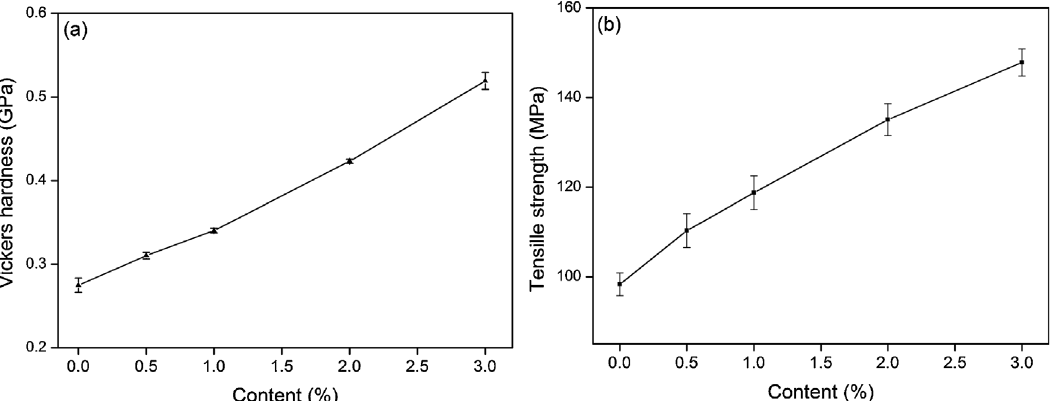
Figure 30. Mechanical properties of Ti 3 C 2 T x /Al composites: Vickers hardness ( a ) and tensile strength ( b ) as a function of Ti 3 C 2 T x content. Reprinted with permission from [66]. Copyright 2020 Elsevier.